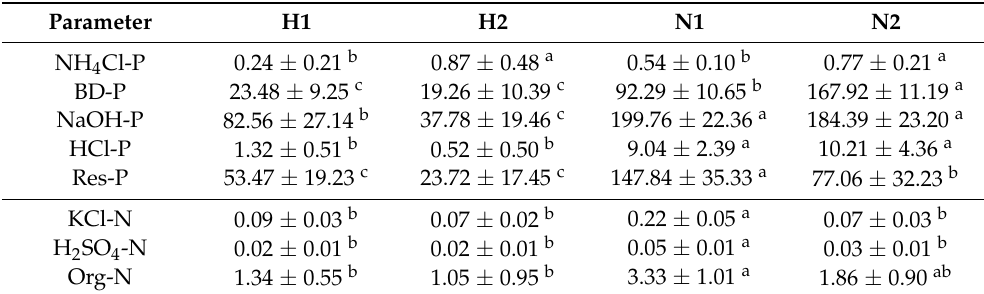
Table 2. Phosphorus and nitrogen fractions in sediments at each sampling site (H1, H2, N1, and N2). Values are mean ± standard deviation of the layered sediments from the same site. The units for phosphorus and nitrogen fractions are mg kg − 1 and g kg − 1 , respectively.